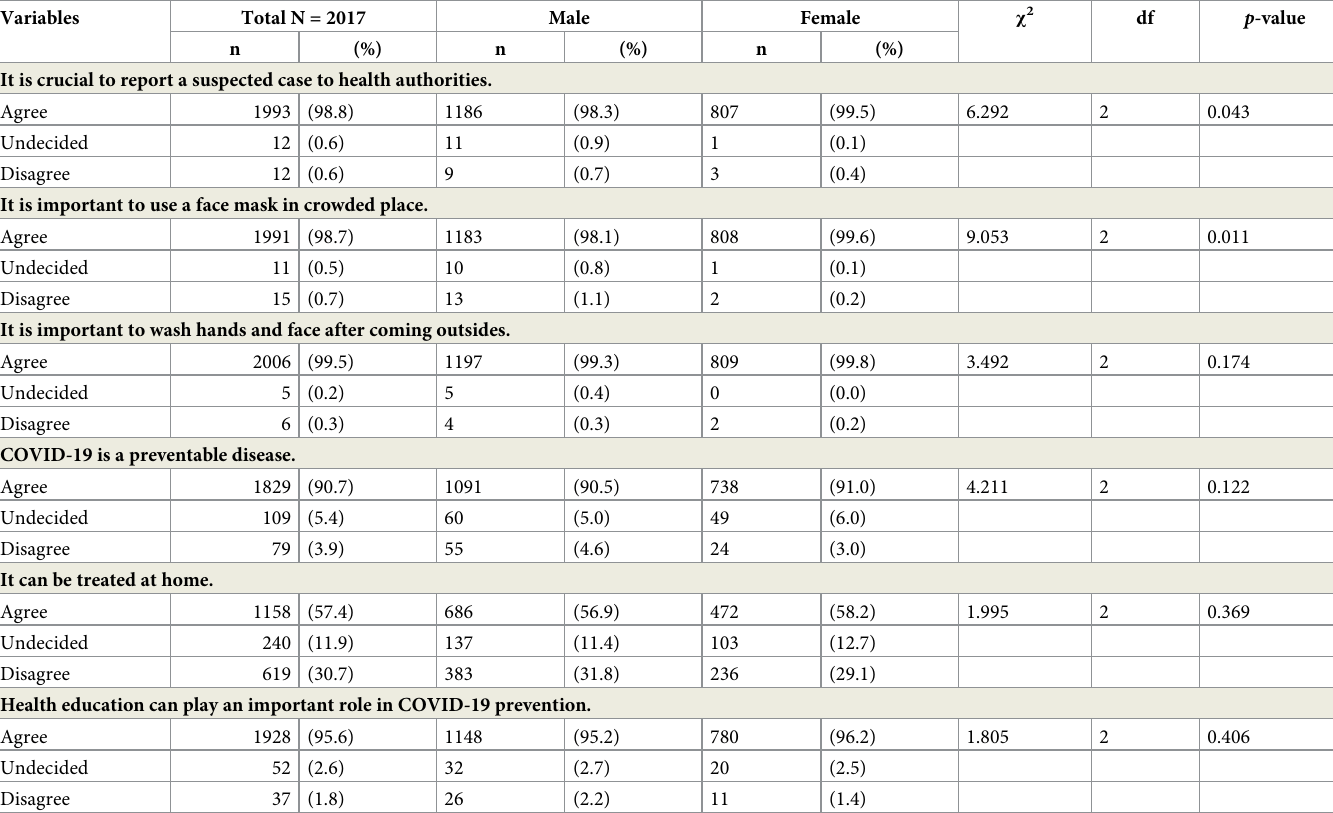
Table 4. Attitude and gender difference of participants (N =